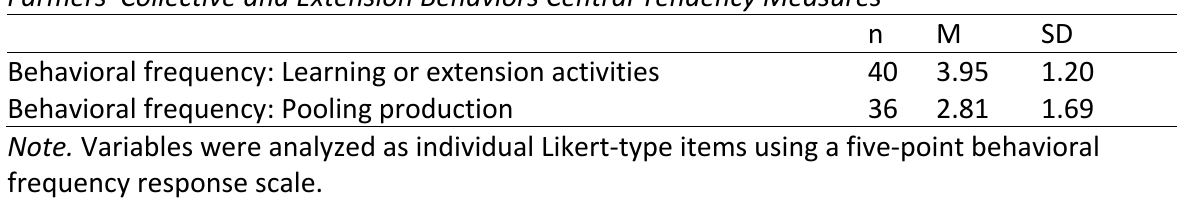
Farmers' Collective and Extension Behaviors Central Tendency